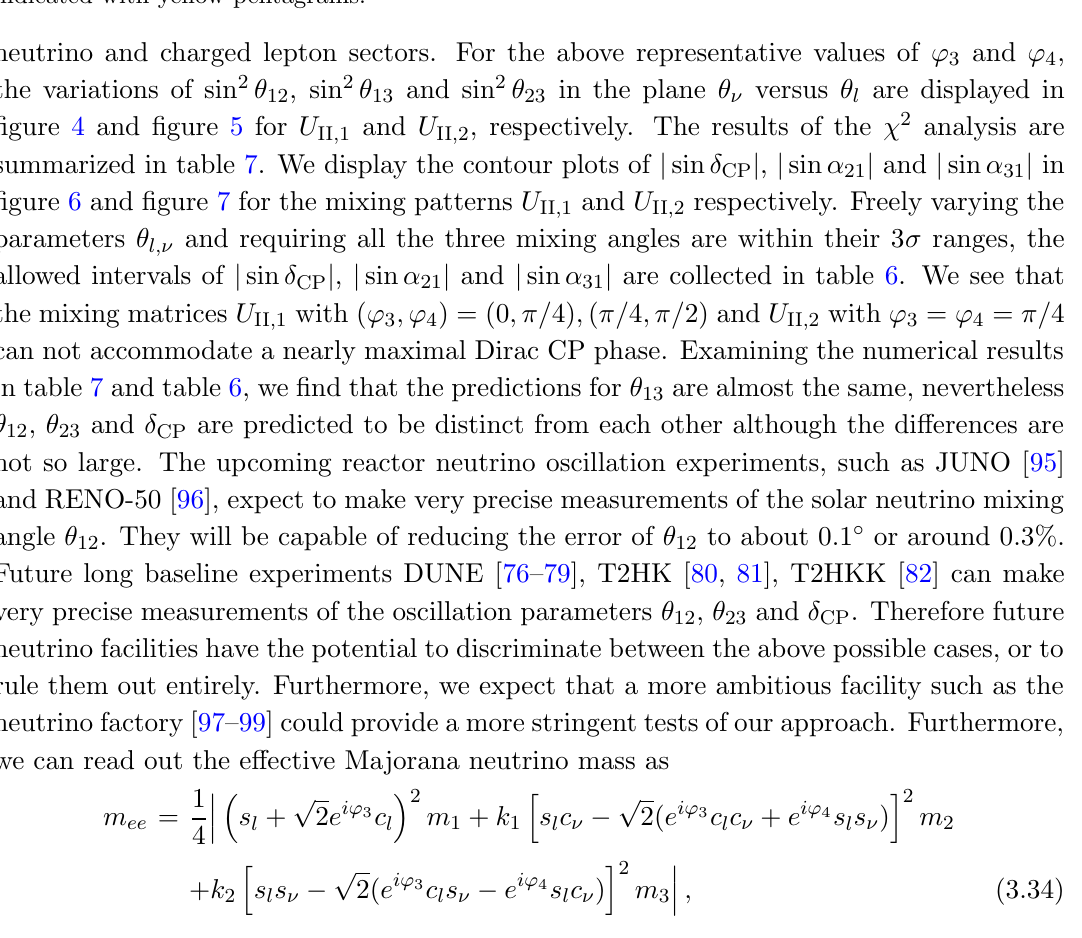
Figure 4 . Contour plots of sin 2 (cid:18) ij in the (cid:18) (cid:23) (cid:0) (cid:18) l plane for U II ; 1 with n = 4. The red, green and blue areas denote the 3 (cid:27) contour regions of sin 2 (cid:18) 13 , sin 2 (cid:18) 12 and sin 2 (cid:18) 23 respectively. The dashed contour lines represent the corresponding experimental best (cid:12)t values. The 3 (cid:27) ranges as well as the best (cid:12)t values of the mixing angles are adapted from [8]. The best (cid:12)tting values of (cid:18) l;(cid:23) are indicated with yellow